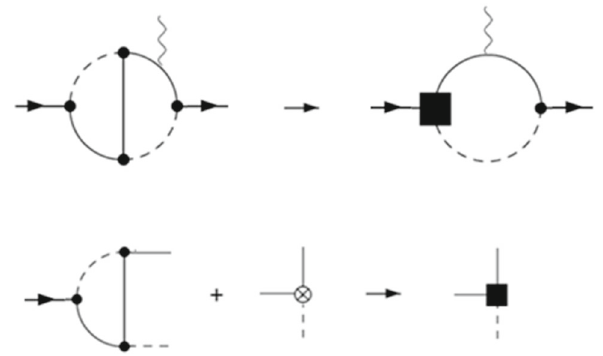
Fig. 3 The schematic diagram for the calculation of the two loop tri- angle diagram belonging to b4 type the effective one loop diagram including black square in the upper right part of Fig. 3. Then the factor of this diagram’s contribution to muon MDM can be